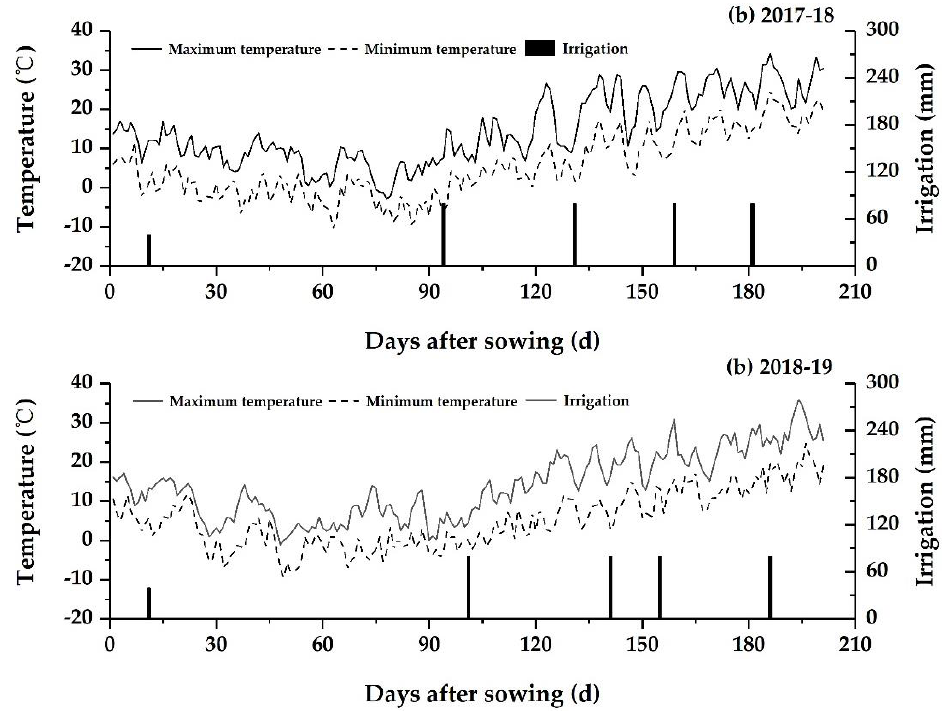
Figure 1. The values recorded for temperature and irrigation events during the experiment.